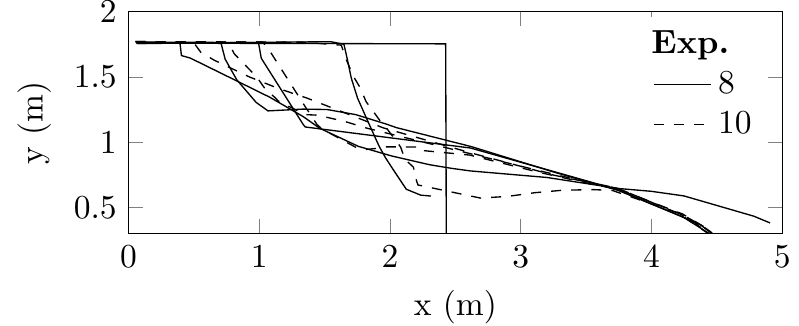
Figure 3.10: Profiles plotted at 0, 180, 410, 600 and 810 seconds for experi- ments 8 and